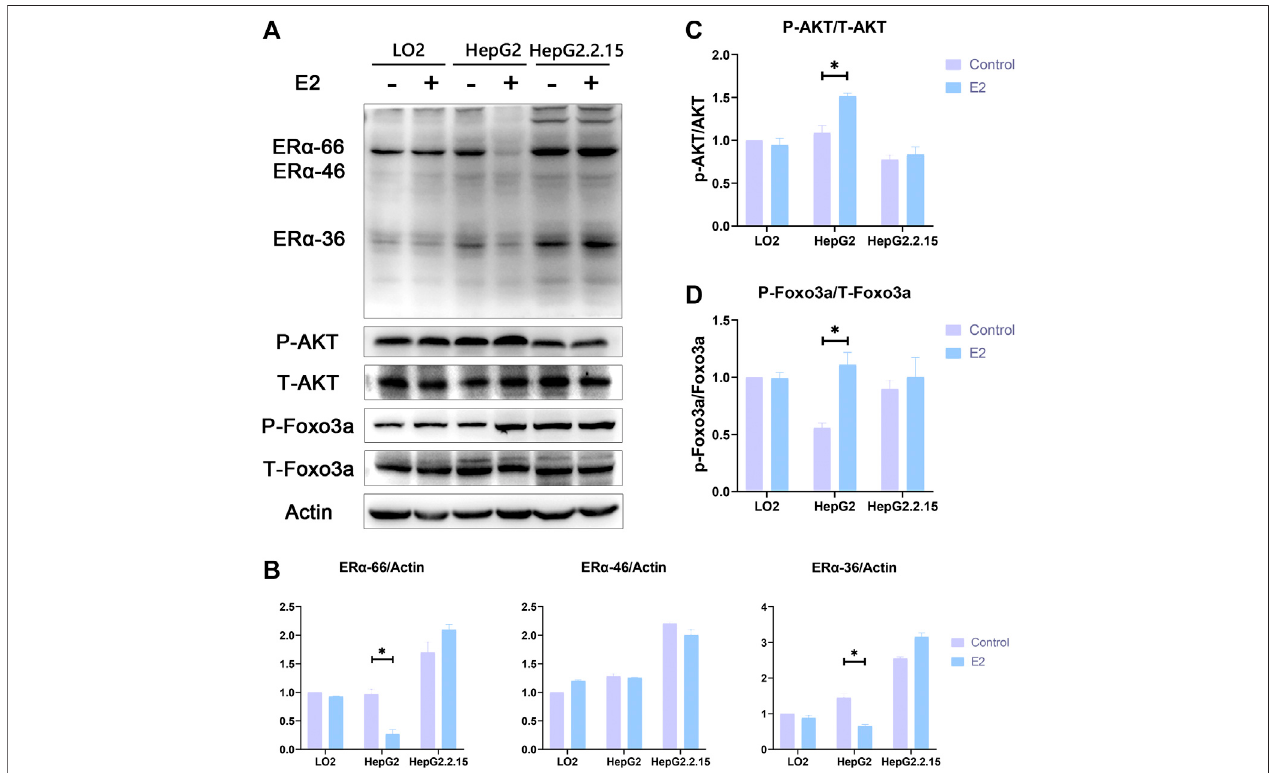
FIGURE6|(A) .Theeffects of17 β -estradiolon theexpression levelsofER α , p -Akt, p -Foxo3a,ER α -36,t-Akt,and t-Foxo3ainHepG2,HepG2.2.15, andLO2 cells treated with 17 β -estradiol (0.125 μ g/ml) for 48 h, as revealed by Western blotting. (B-D) The effects of 17 β -estradiol on ER α -36, ER α -46, ER α -66, p -Akt/t-Akt, and p -Foxo3a/t-Foxo3a levels, respectively. * p < 0.05 compared to the control